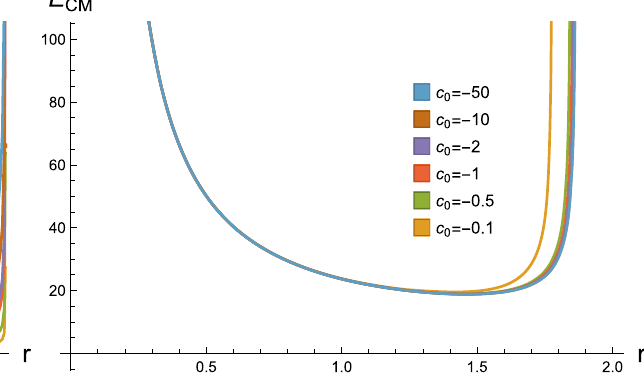
a = 0 . 5 (left-panel) as well as m = M = 1, L 1 = − 4, L 2 = 50, ˆ α = 0 . 9 and a = 0 . 5 (right-panel). It is clear that the CM energy blows up at the